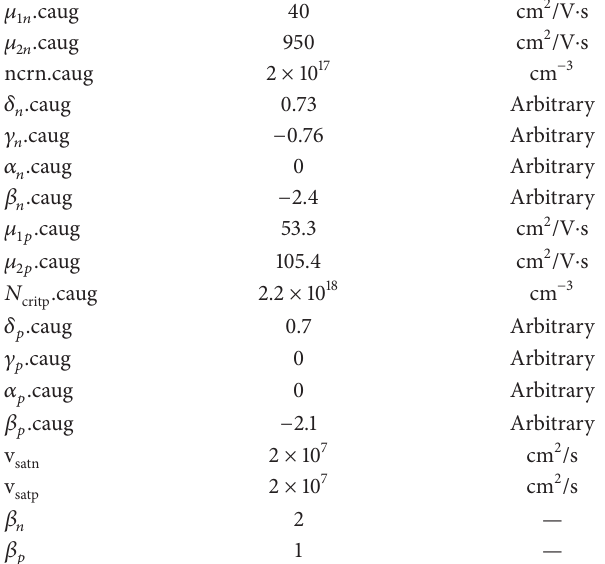
Table3:Mobilityparametersusedin4H-SiCbasedMOSFETdevice